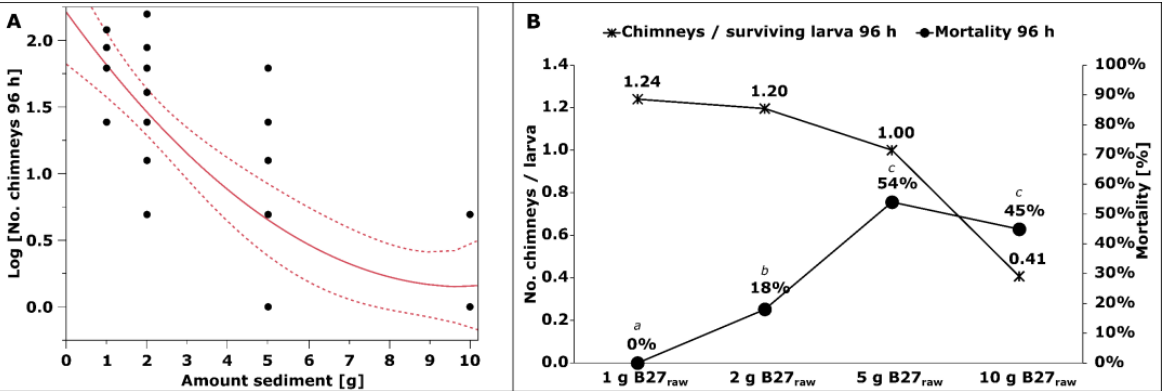
Figure 4. Chimneys build out of the fine-grained test sediments from the settling ponds at the B27 by the larvae exposed to them and larval mortality at 96 h (experiment 2, sample sizes: Table 1). Significant differences indicated by letters. ( A ) Nonlinear regression of the number of chimneys depending on the amount of sediment from the B27 (ANOVA: F (2, 36) = 41.6079, p < 0.0001 *). ( B ) The number of chimneys at 96 h per surviving larva at 96 h and the larval mortality at 96 h in the four different concentrations of B27 sediment. (1 g B27 raw : 1 g B27 sediment, 9 g sand; 2 g B27 raw : 2 g B27 sediment, 8 g sand; 5 g B27 raw : 5 g B27 sediment, 5 g sand; 10 g B27 raw : 10 g B27 sediment (pure, no sand); all: 100 mL filtered water).